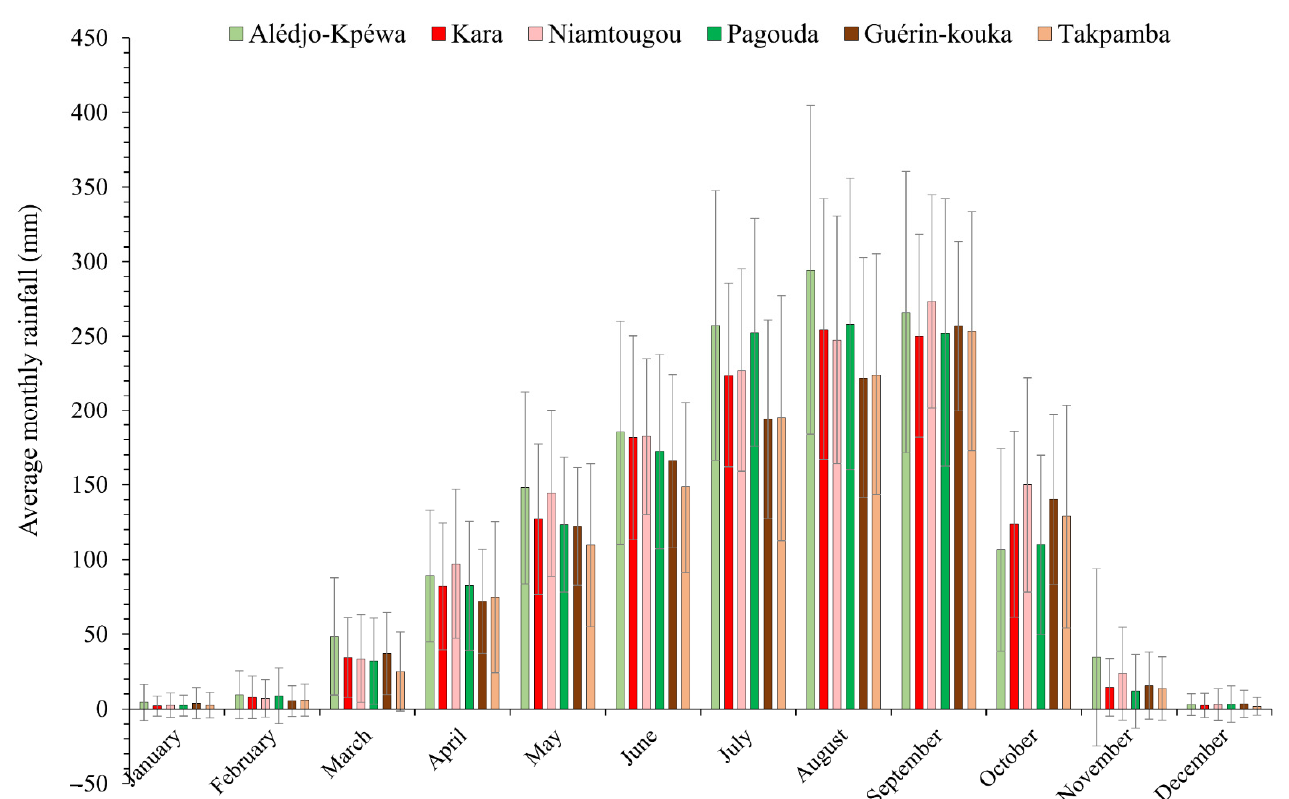
Figure 2. Average level of monthly rainfall at the studied stations between 1961 and 2020 (the location of the stations is presented in Figure 1).